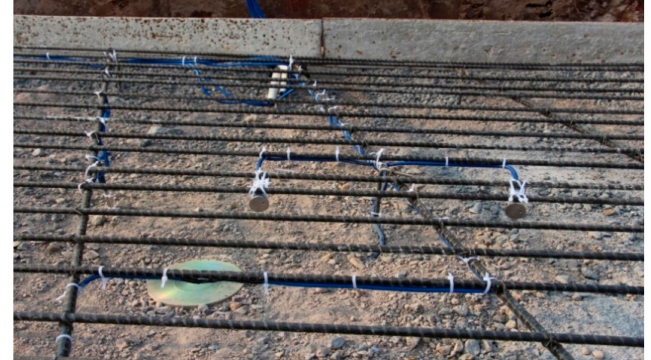
Figure 2. The layout of the longitudinal BFRP reinforcement on transverse